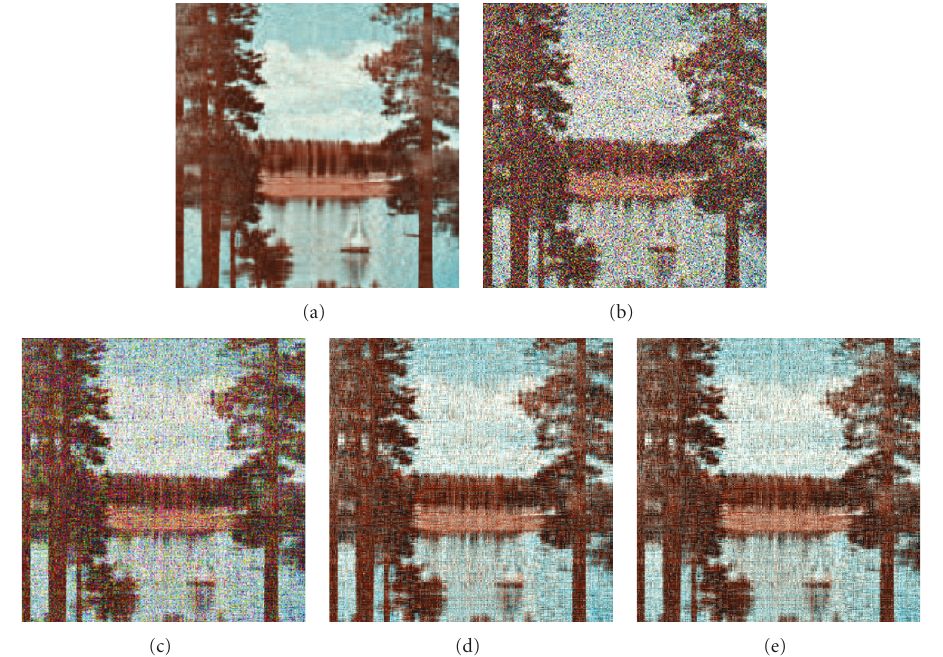
Figure 1: (a) Nonnoisy image. (b) Image to be processed, impaired by an additive white noise, with SNR = 8 . 1 dB. (c) Channel-by-channel SVD-based filtering of parameter K = 30. (d) Lower-rank (30,30,2) approximation. (e) MWF-(30,30,2) filtering.